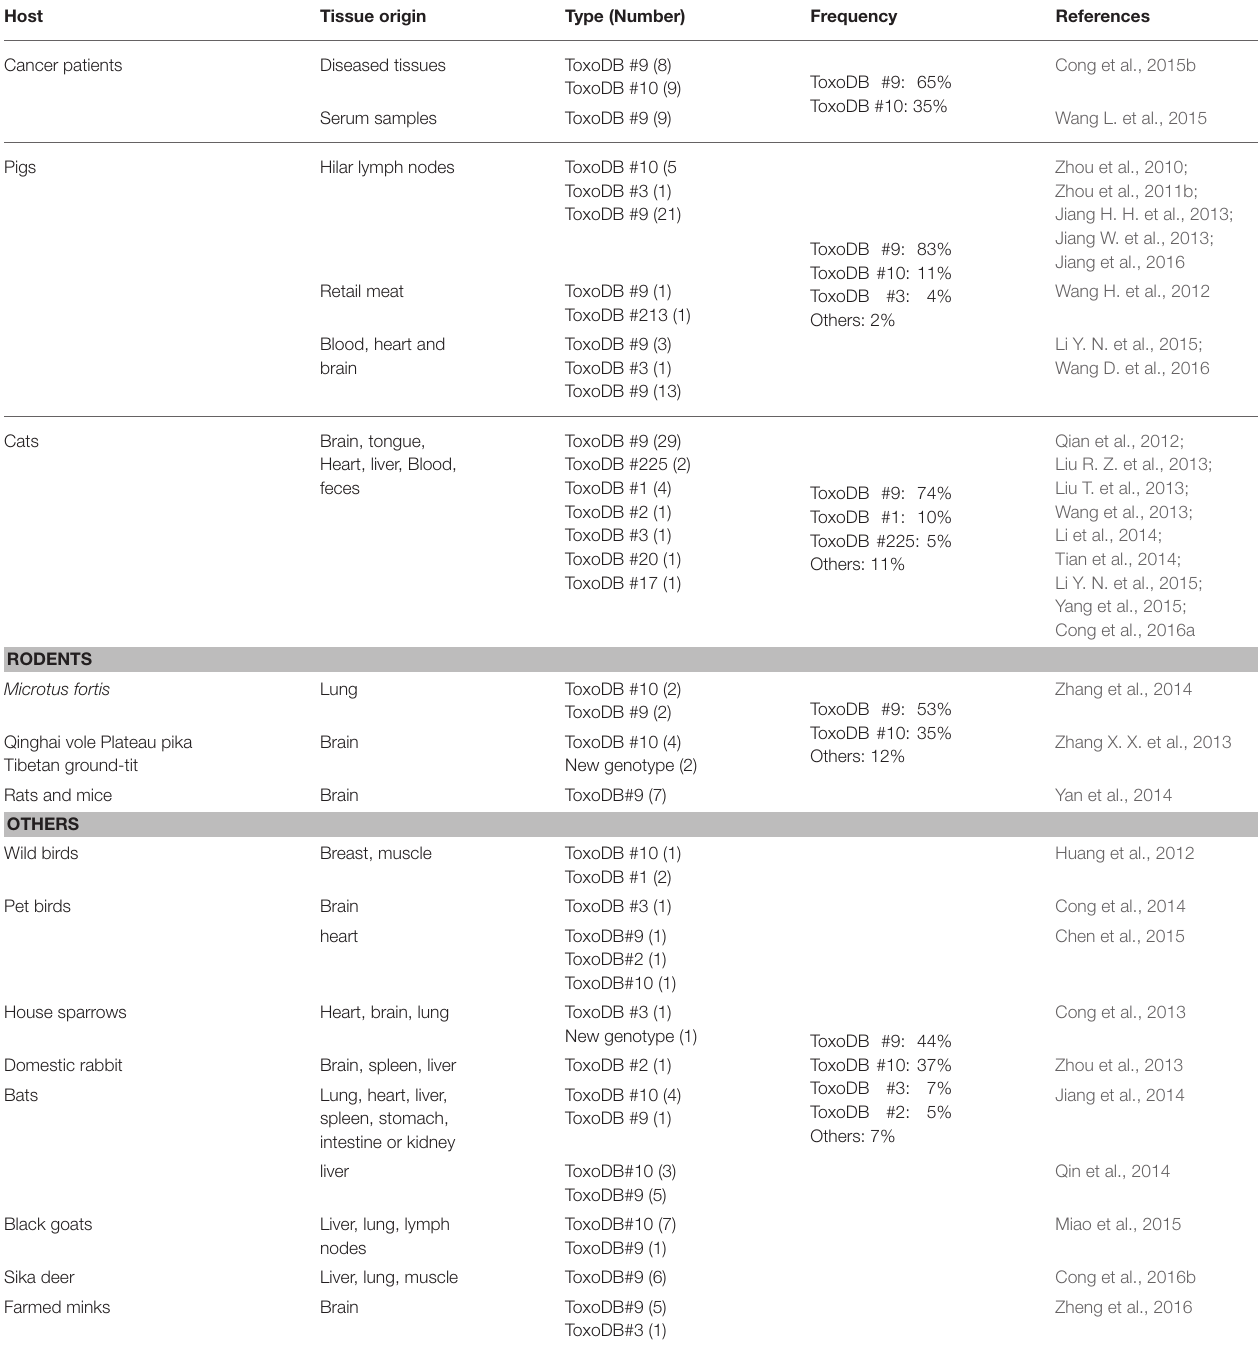
TABLE 2 | Genotypes of T. gondii parasites prevalent in